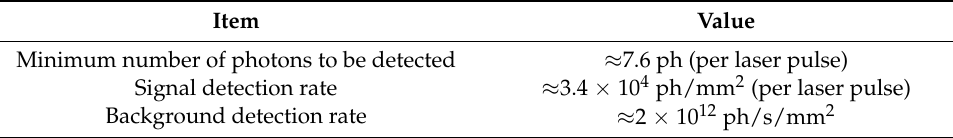
Figure 2. Typical spectral density of the light produced by a halogen lamp. Table 3. Minimum number of photons to be detected and expected photon rates.